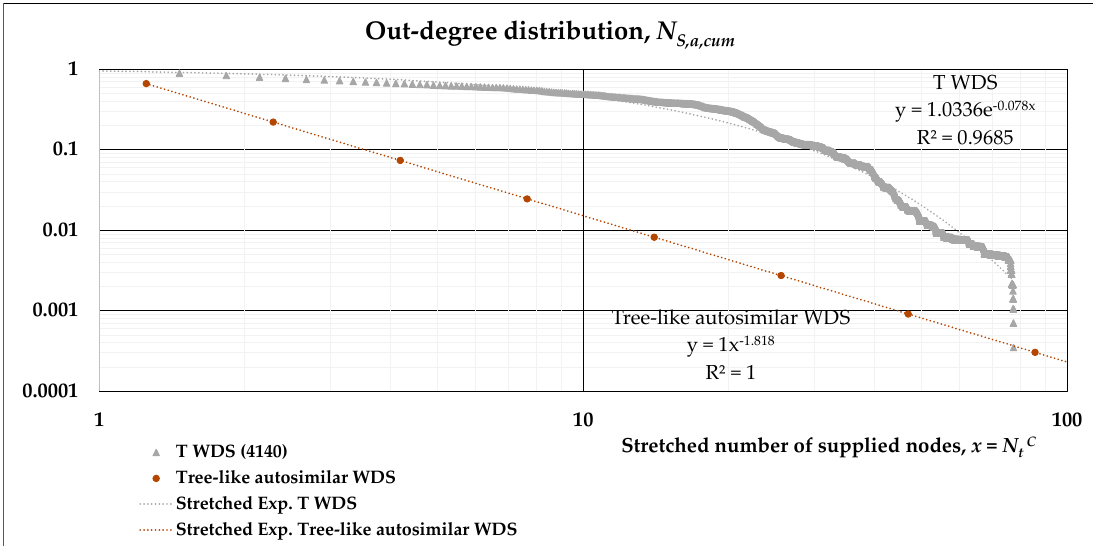
Figure 4. Cumulative out-degree distribution functions for G WDS, with stretched exponential fitting.